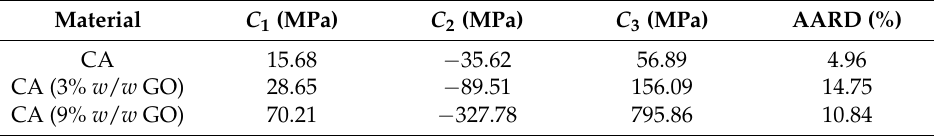
Table 4. Parameters and deviations for the Yeoh model.